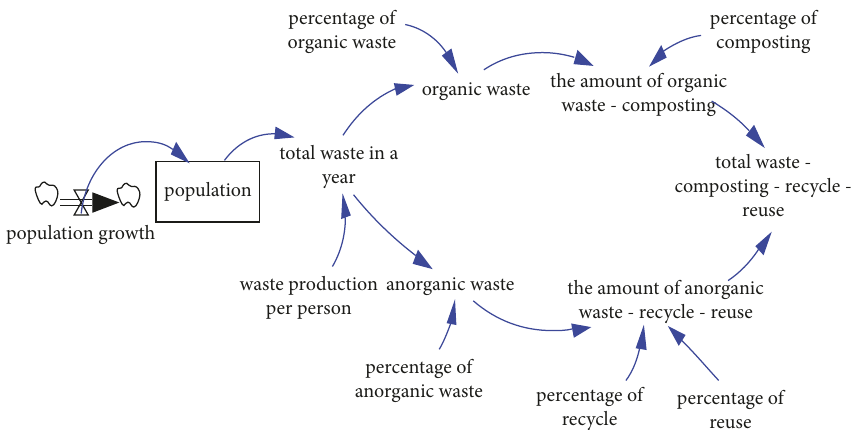
Figure 3: SFD of organic and inorganic waste processing with total accumulation of